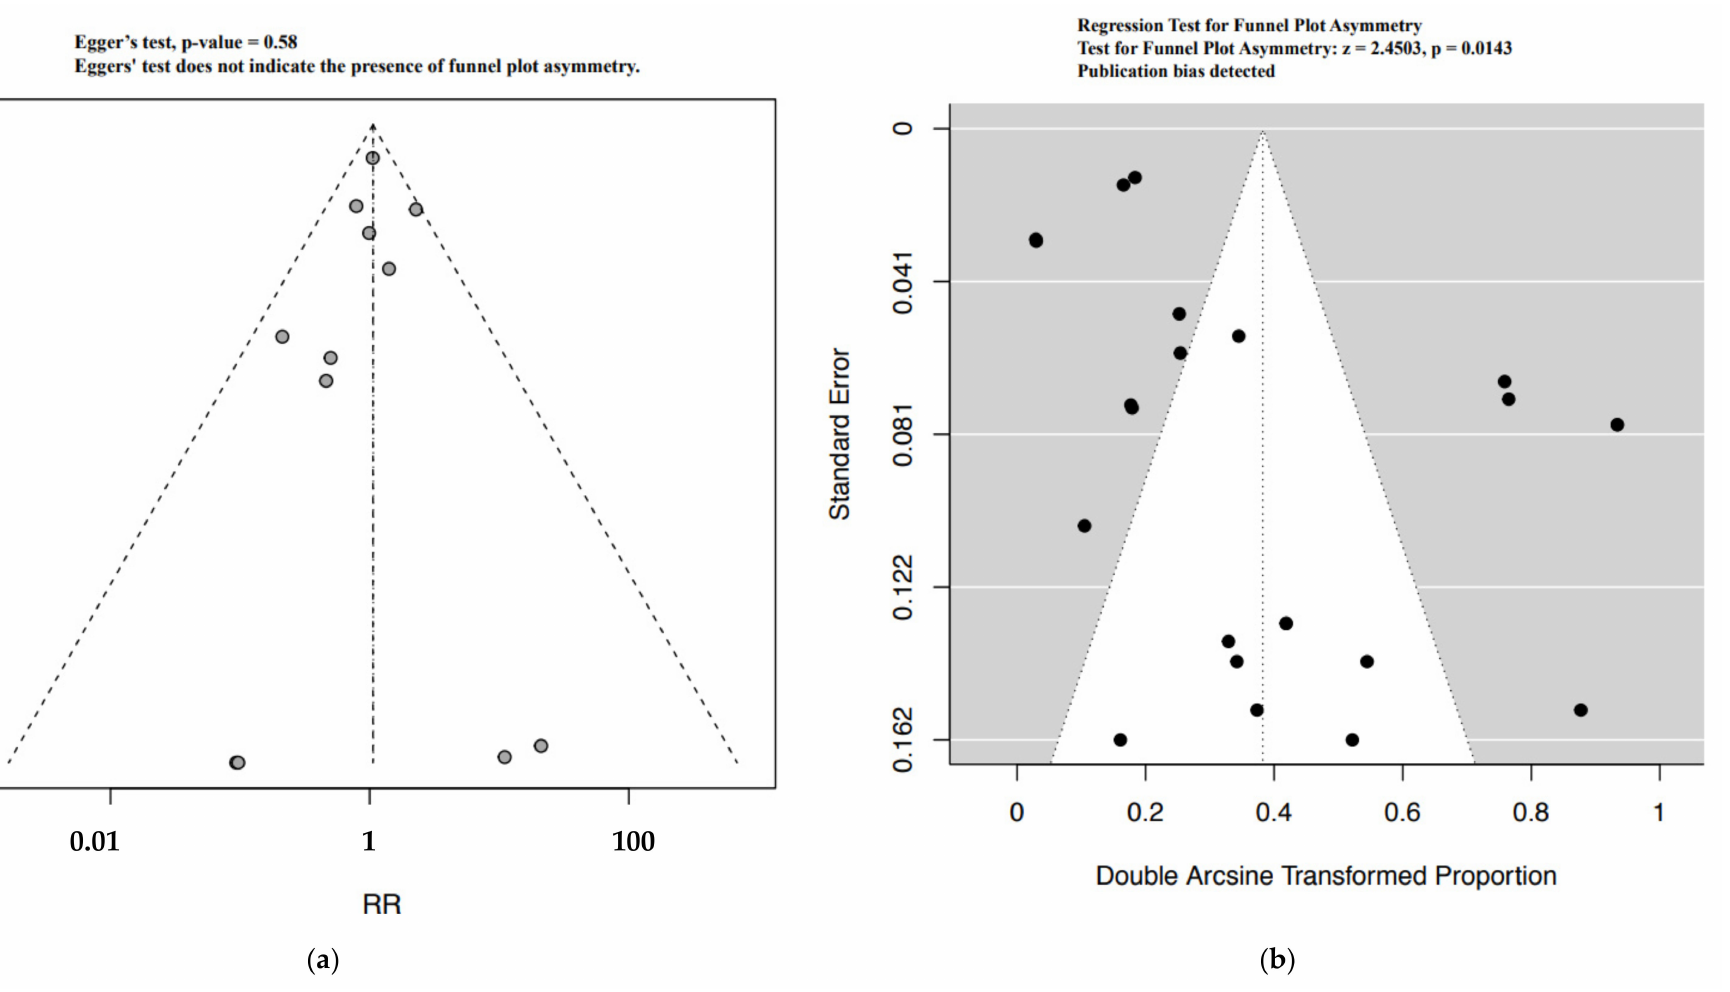
Figure 7. Funnel plots hypoglycemia—RCT ( a ) and proportion based meta-analysis ( b